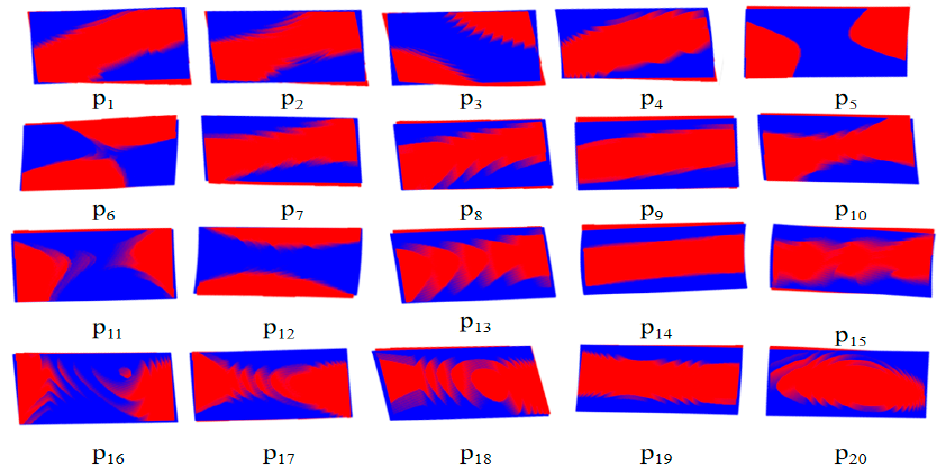
Figure 9. Point cloud registration for each